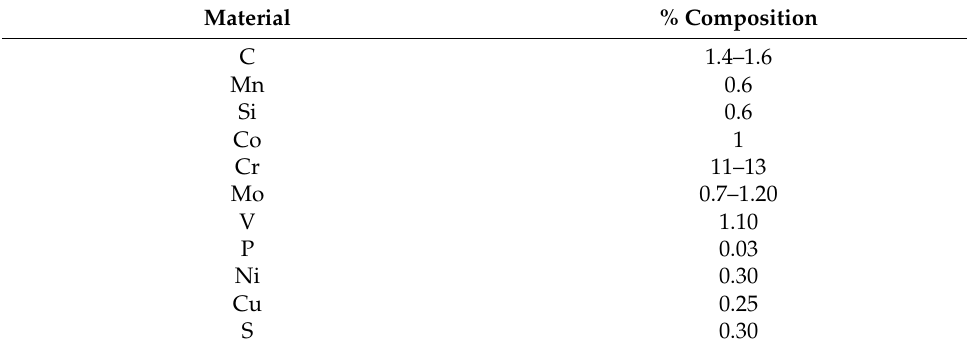
Table 2. Chemical composition of D2 die steel [32].